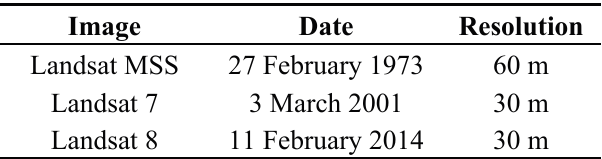
Table 1. Satellite data used for NDVI analysis in the forest corridor landscape of Biligiri Rangaswamy Temple Tiger Reserve